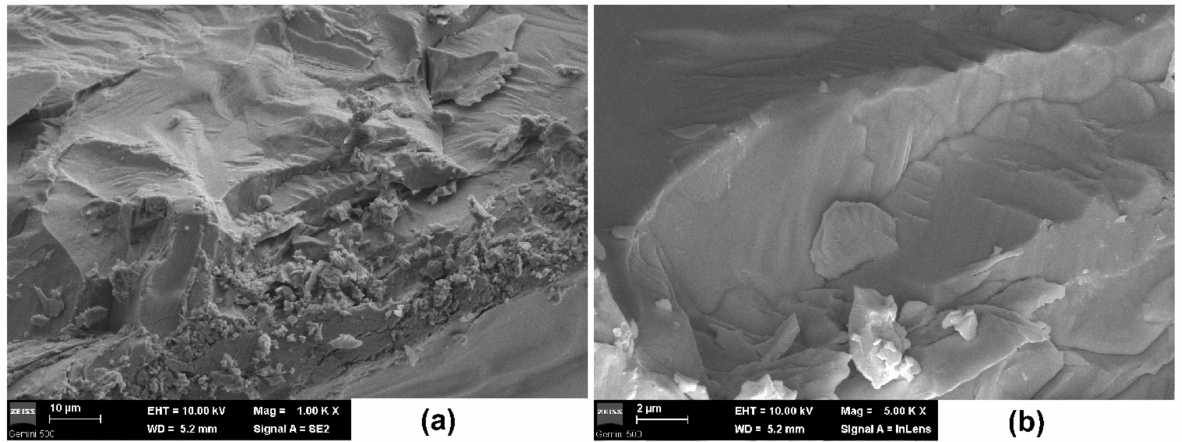
Figure 4. SEM images with different magnifications: ( a ) 10 µ m; ( b ) 2 µ